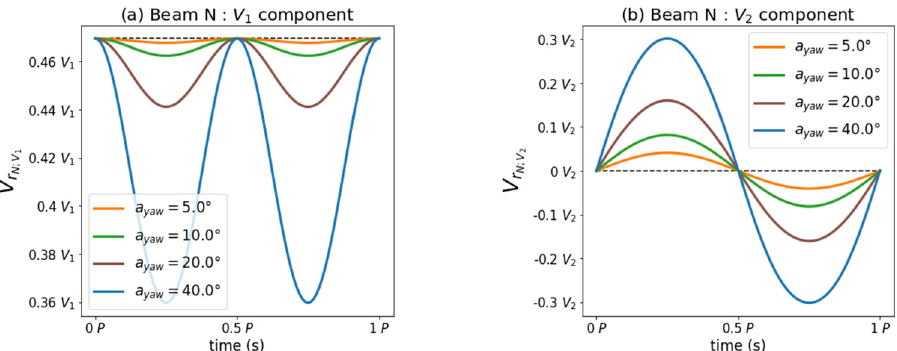
Figure 8. Influence of a sinusoidal yaw motion on the radial wind speed measurement of the beam N as a function of the incident wind components V 1 and V 2 . All the results are plotted as a function of the amplitude of the motion and the time relative to the period of the sinusoid. ( a ) Variation of the V r component. ( b ) Variation of the V r N ; V 1 N ; V 2 component.